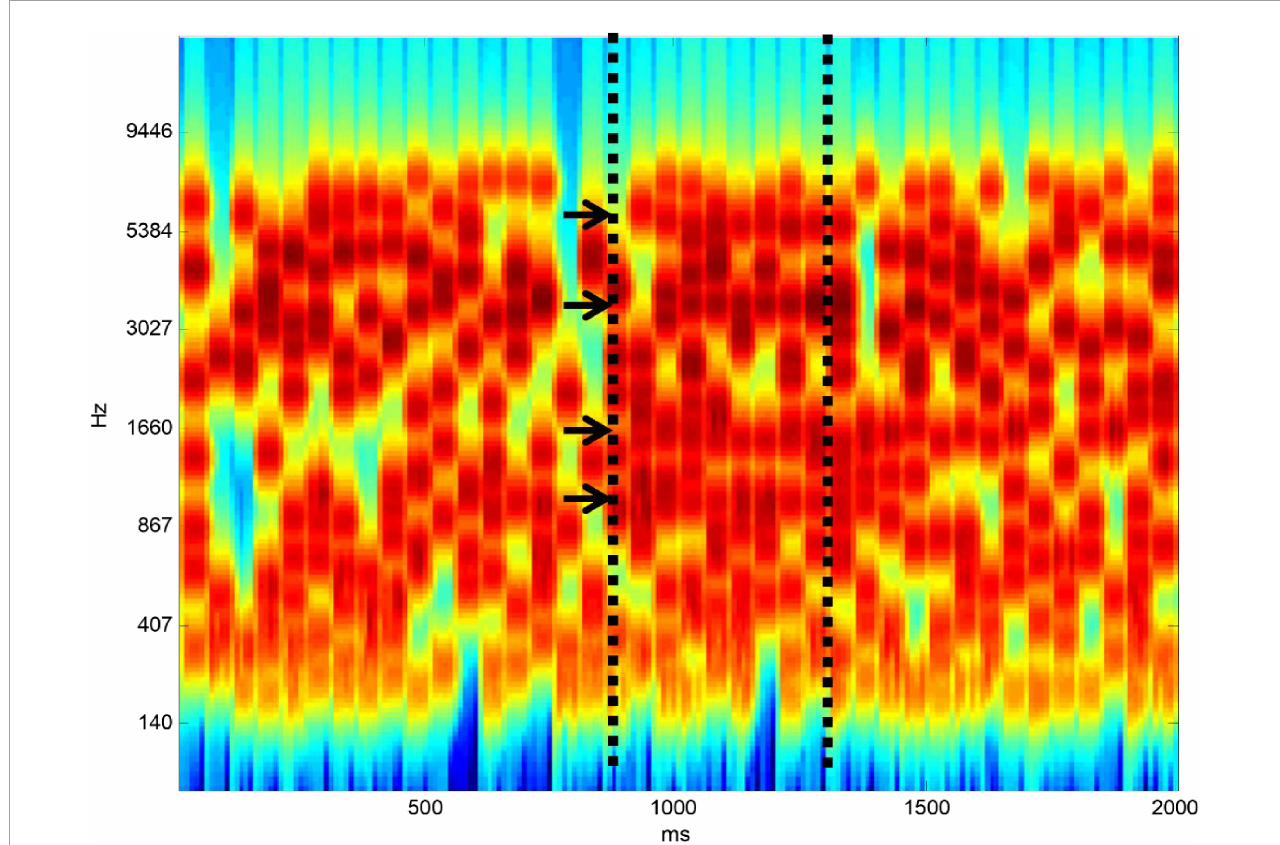
FIGURE1 Figure-ground stimulus. The “ground” stimulus contains random elements distributed in frequency-time space. At a certain point in time, shown by the first vertical dashed line, a certain number of elements (four here–shown by arrows) are constrained to remain constant from one time frame to the next. If there are enough elements and they are on for long enough a “figure” emerges perceptually from the background.